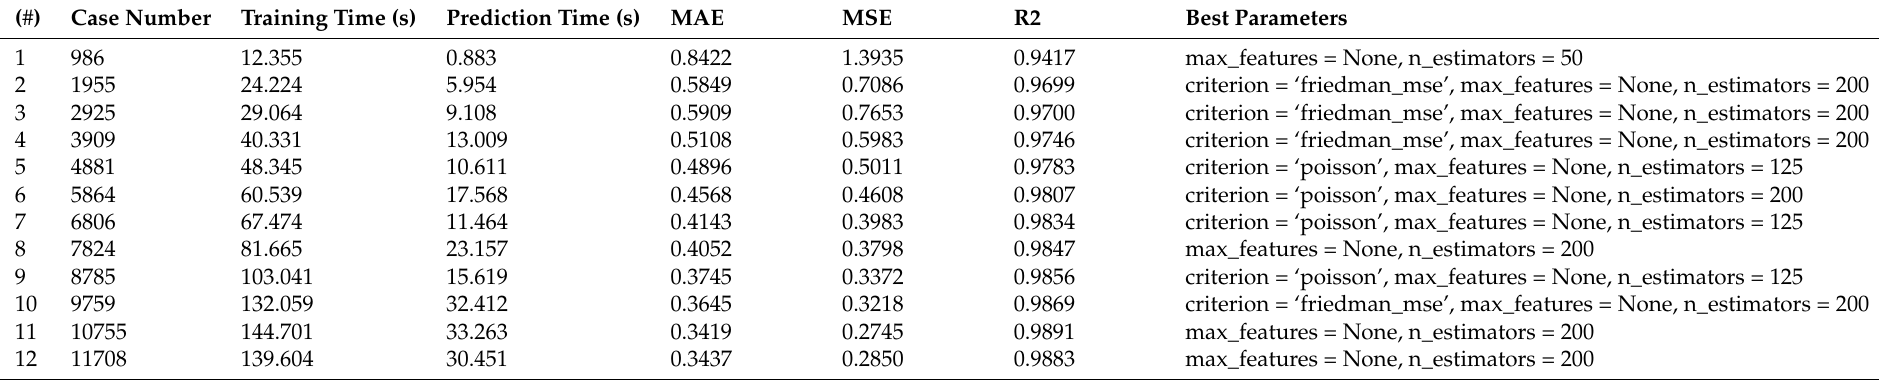
Table A3. Results of running the model with: ExtraTreesRegressor.